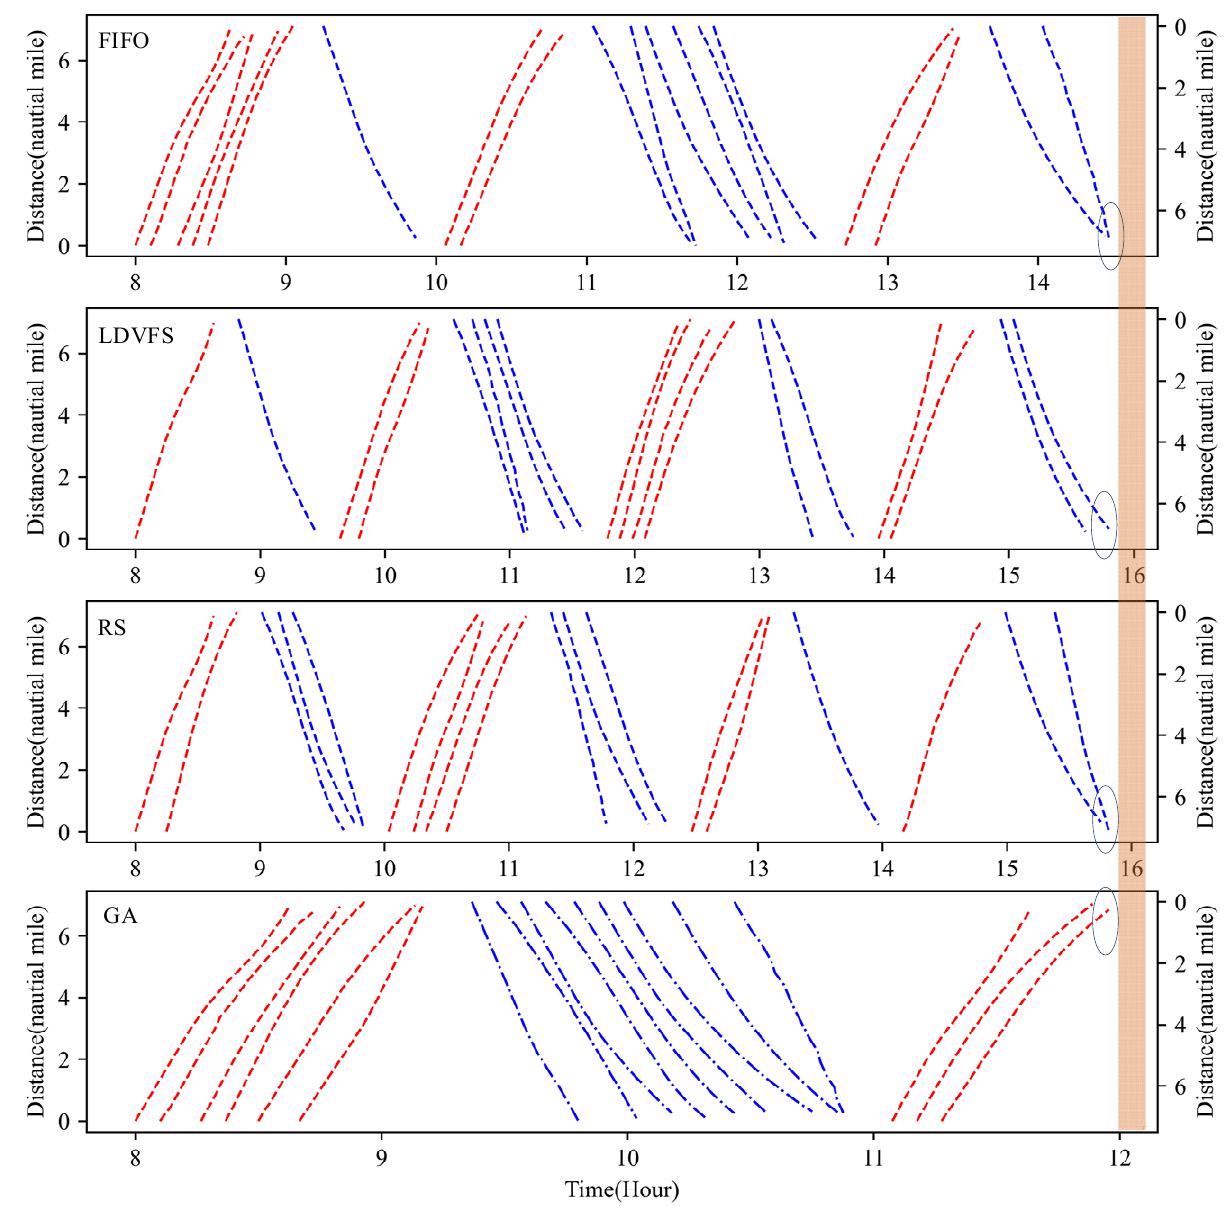
Figure 15. Space − time trajectories of the solutions of different heuristics.